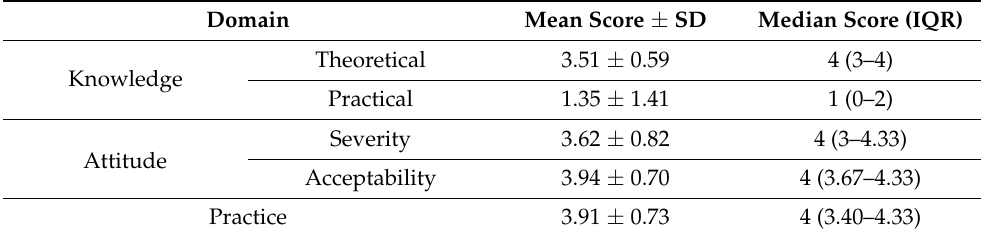
Table 2. Mean and median scores for knowledge, attitudes, and practices.